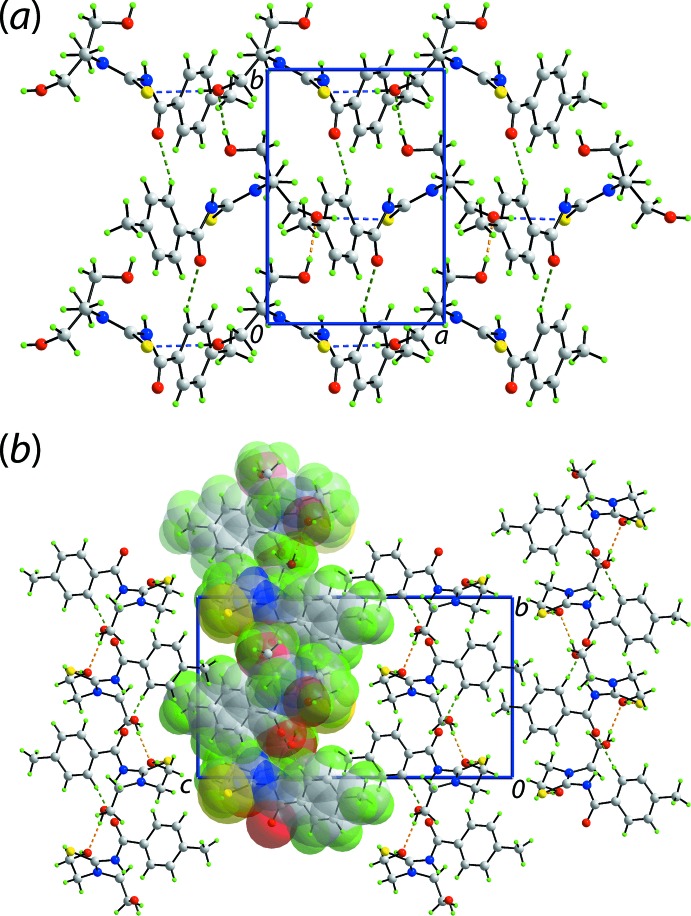
Views of the mol­ecular packing in (I): (a) supra­molecular layer in the ab plane sustained by hy­droxy-O—H⋯O(hy­droxy), hy­droxy-O—H⋯S(thione) and aryl-C—H⋯O(carbon­yl) inter­actions, and (b) view of the unit-cell contents in projection down the a axis, highlighting the stacking of layers; one layer is represented in space-filling mode. The O—H⋯O, O—H⋯S and C–H⋯O inter­actions are shown as orange, blue and green dashed lines, respectively.